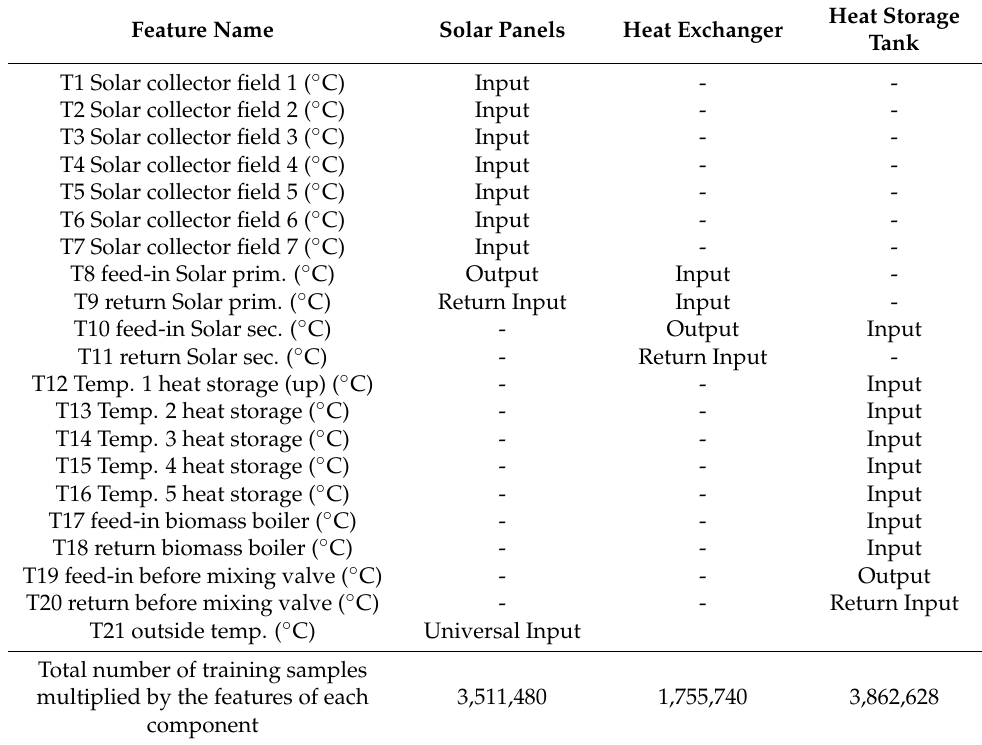
Table 1. The features of the dataset and how they are used within each